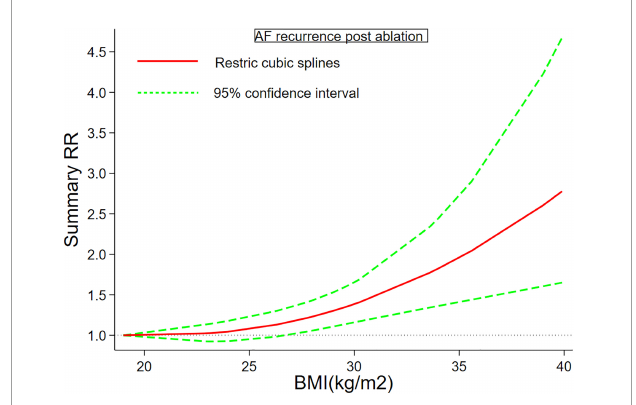
FIGURE3 Body mass index and atrial fibrillation recurrence in patients undergoing radiofrequency ablation based on a non-linear dose-response analysis. The solid and dashed lines represent the estimated relative risk and the 95% confidence interval,